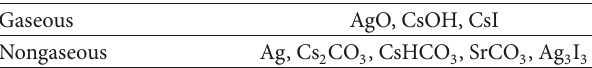
Table 11: Main forms of Cs, Sr, Ag, and